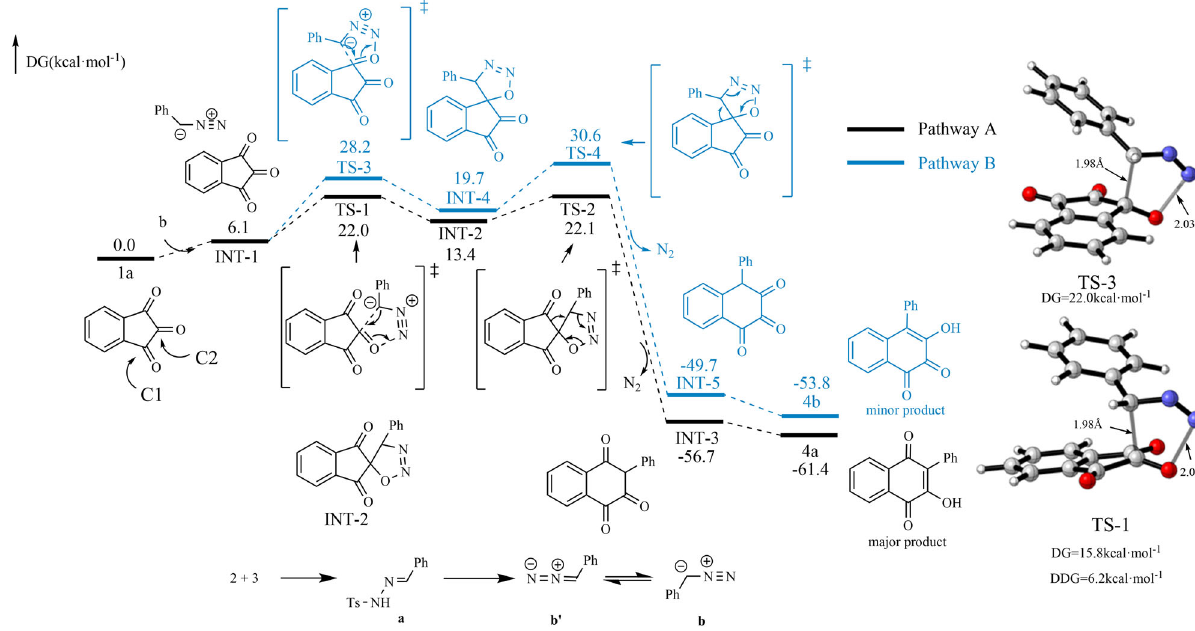
Fig. 6 Calculated reaction pathways and free energy pro fi les for the regioselectivity of the ring-expansion process in acetonitrile solvent. DFT calculations were performed with B3LYP-D3(BJ)-SMD(acetonitrile)/6-311 ++ G(d,p)//B3LYP-D3(BJ)/6-31G(d) (for details see SI, Table S7).